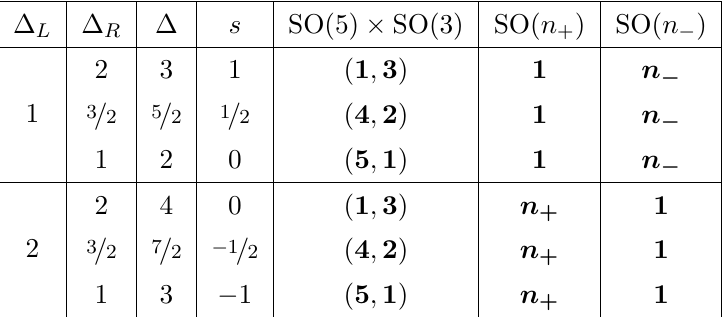
Table 16. Mass spectrum for the SU(4 group GL(6) SO(2 ; n ). (cid:2) (cid:0)